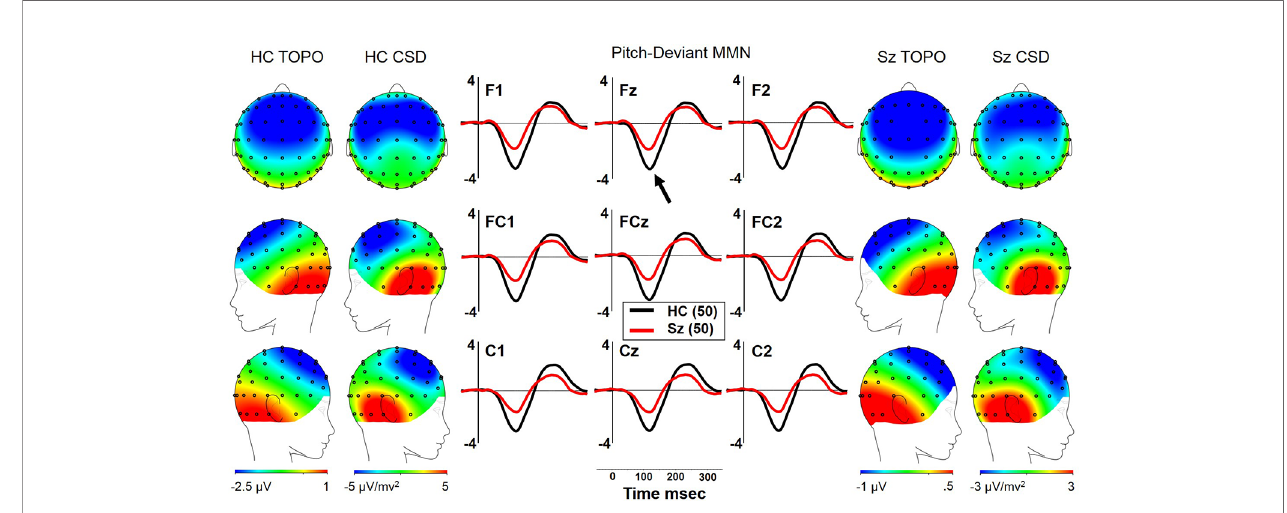
FIGURE 1 | pMMN in long-term schizophrenia. HC, Healthy Control subjects; Sz, Long-term Schizophrenia subjects; Topo, Voltage topography; CSD, Current Source Density